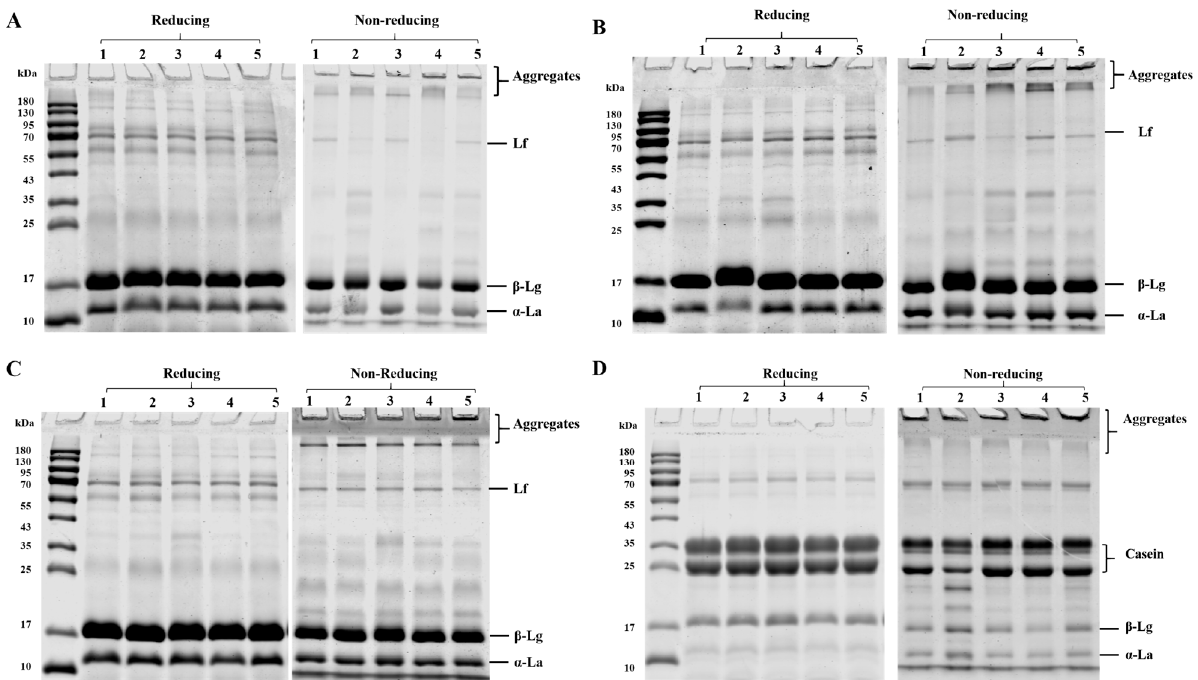
Figure 3. Sodium dodecyl sulphate–polyacrylamide gel electrophoretograms (SDS–PAGE) under reducing and no-reducing conditions of D70 ( A ), D90 ( B ), WPC ( C ), and SMP ( D ).